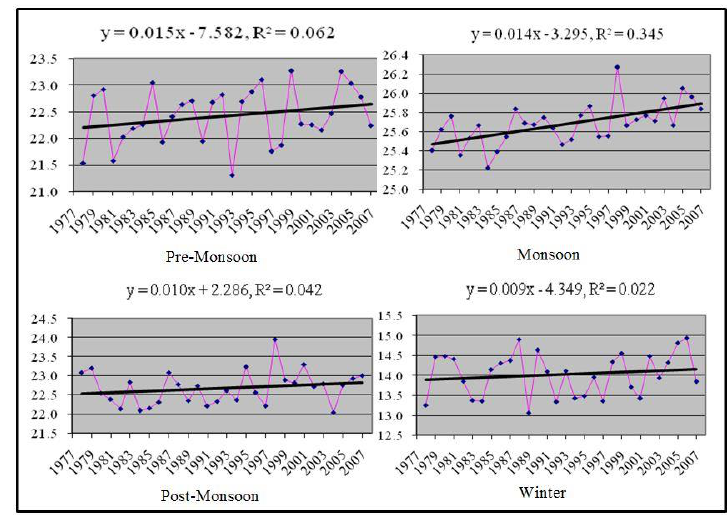
Figure 4. Average mean annual minimum temperature in different seasons.